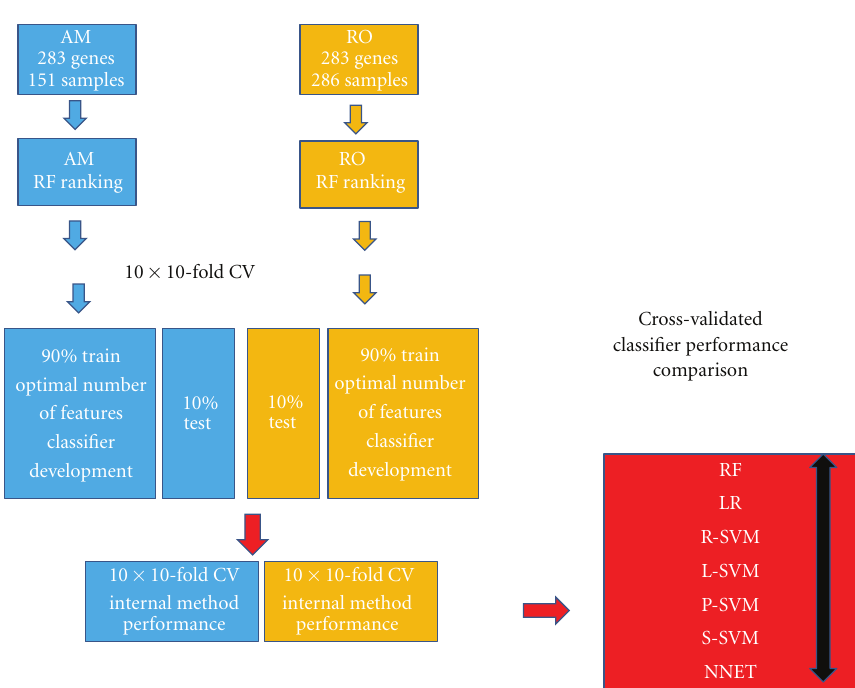
Figure 2: Internal validation procedure. The two datasets, AM (blue) and RO (orange) composed of the 283 rank-significant genes and 151 or 286 samples, respectively, were used for internal performance evaluation. These datasets were first individually used to rank each feature by their random forest variable importance value (RF ranking). These ranks were separately used for selecting the optimal number of features by adding one feature using the same classification method, using a 10-times repeated 10-fold cross-validation procedure. The AM and RO 10-times cross-validation results using the same classification method were combined, and the mean classification performance of each method was compared.